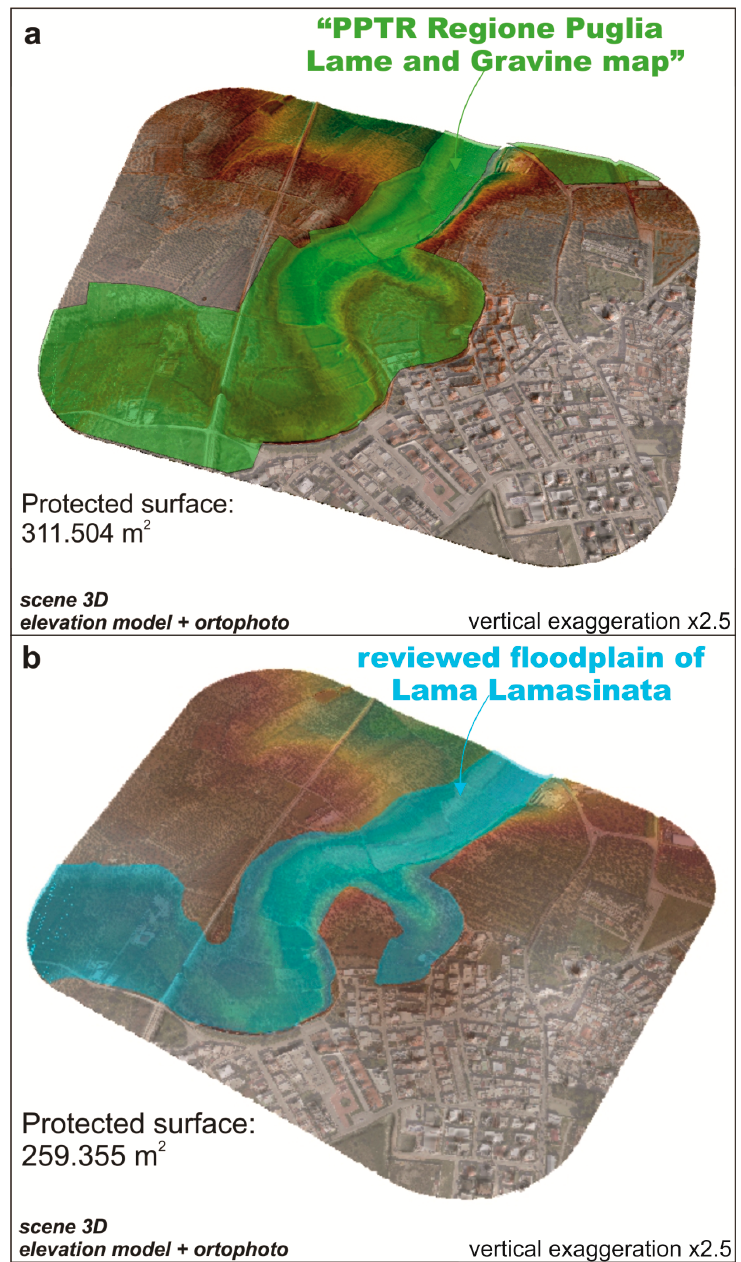
Figure 12. Comparison between the floodplain of Lama Lamasinata as shown in the PPTR ( a ) and in this study ( b ).